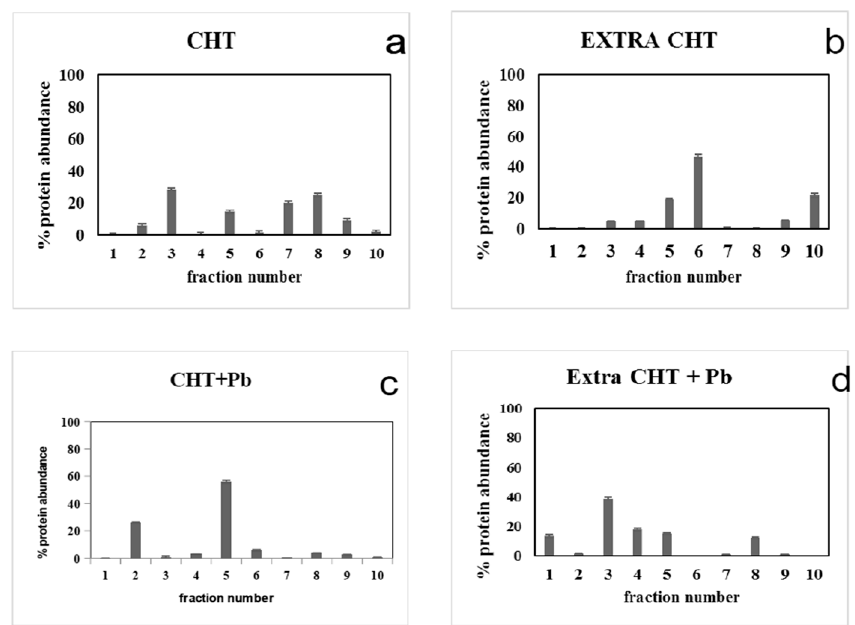
Figure 5. Histograms of protein distribution after micro 2D electrophoresis of crude homogenate (CHT and CHT+ Pb 2+ , panels ( a ) and ( c ), respectively) and extracellular proteins (Extra CHT and Extra CHT + Pb 2+ , panels ( b ) and ( d ), respectively) of T. thermophilus . On x axis are indicated the number of fractions. Y axis indicates the percentage. Each sample was tested in triplicate.